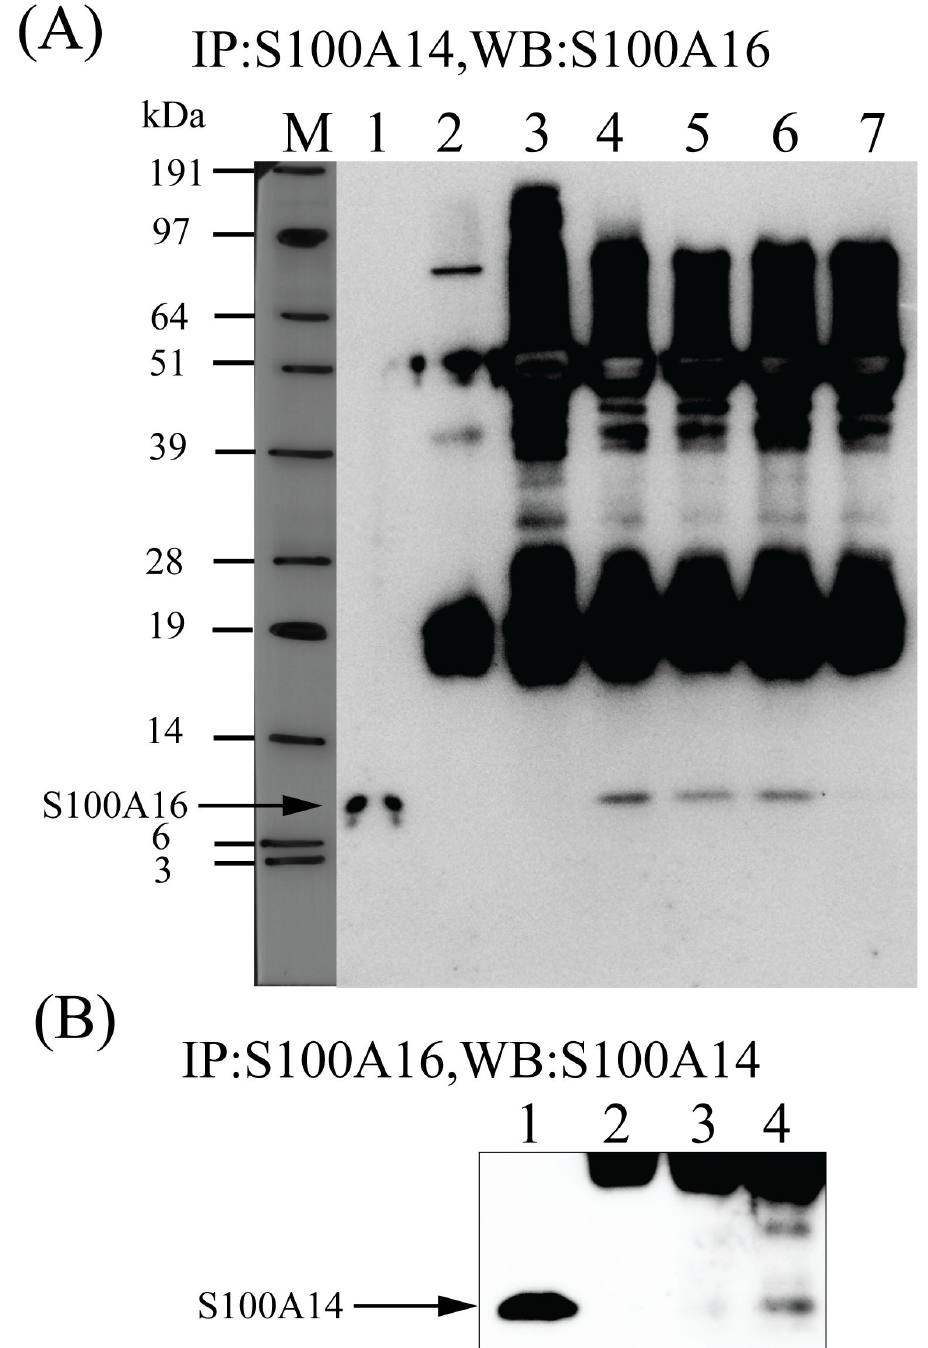
Figure 1. Co-immunoprecipitation of S100A14 and S100A16 in oral cancer cells. Five hundred micrograms of pre-cleared cell extract from CaLH3 cells was incubated with anti-S100A14 antibody in the presence of 0-2 mM CaCl EDTA (A) or anti-S100A16 antibody (B), followed by incubation with Protein A/G PLUS-Agarose. Immune complexes were immunoblotted with anti-S100A16 (A) or anti-S100A14 antibody (B). Only lysate (without any antibody) and anti-MMP9 antibody were used as controls for the Co-IP. (A) M, molecular weight marker; lane 1, input; lane 2, only lysate; lane 3, control anti-MMP9 antibody; lanes 4-7 (anti-S100A14 antibody): lane 4, 0 mM CaCl with 5 mM EDTA. (B) lane 1, input; lane 2, only lysate; lane 3, control anti-MMP9 antibody; lane 4, anti-S100A16 antibody with 0 mM CaCl . 2 doi: 10.1371/journal.pone.0076058.g001 PLOS ONE |